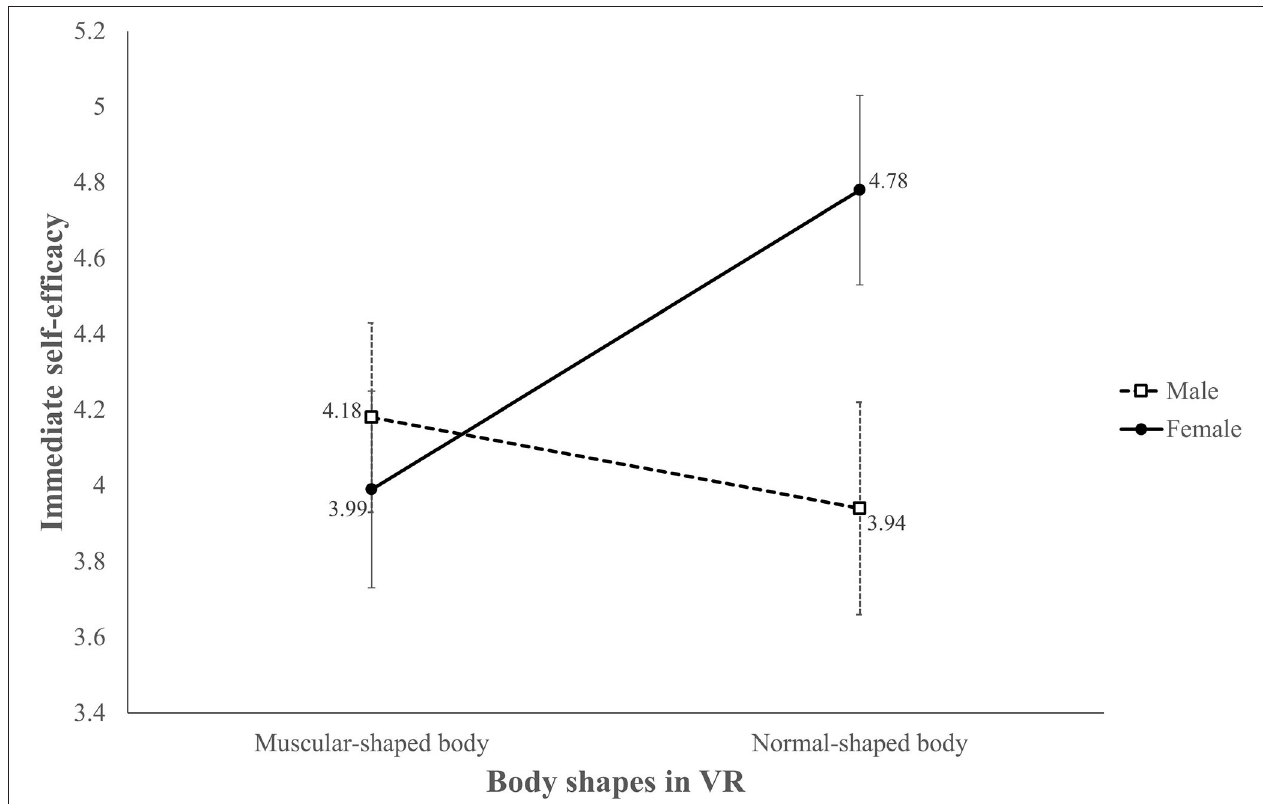
FIGURE 5 | Adjusted mean score of immediate self-efficacy for core